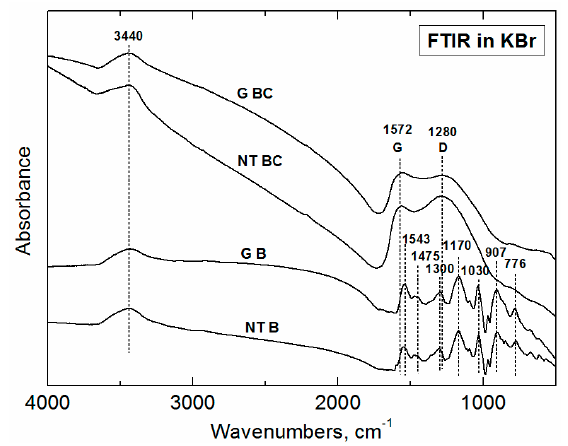
Figure 4. FTIR spectra of original globular (G) and nanotubular (NT) polypyrrole bases before (B) and after (BC) carbonization.